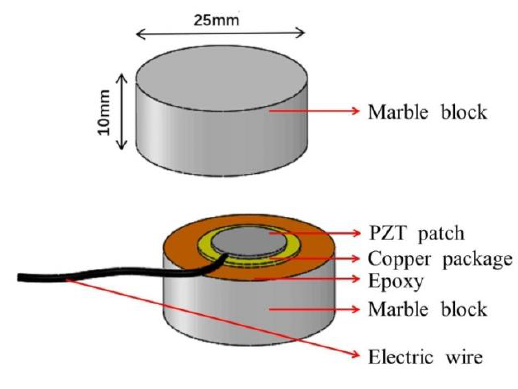
Figure 2. Structure of an SA.